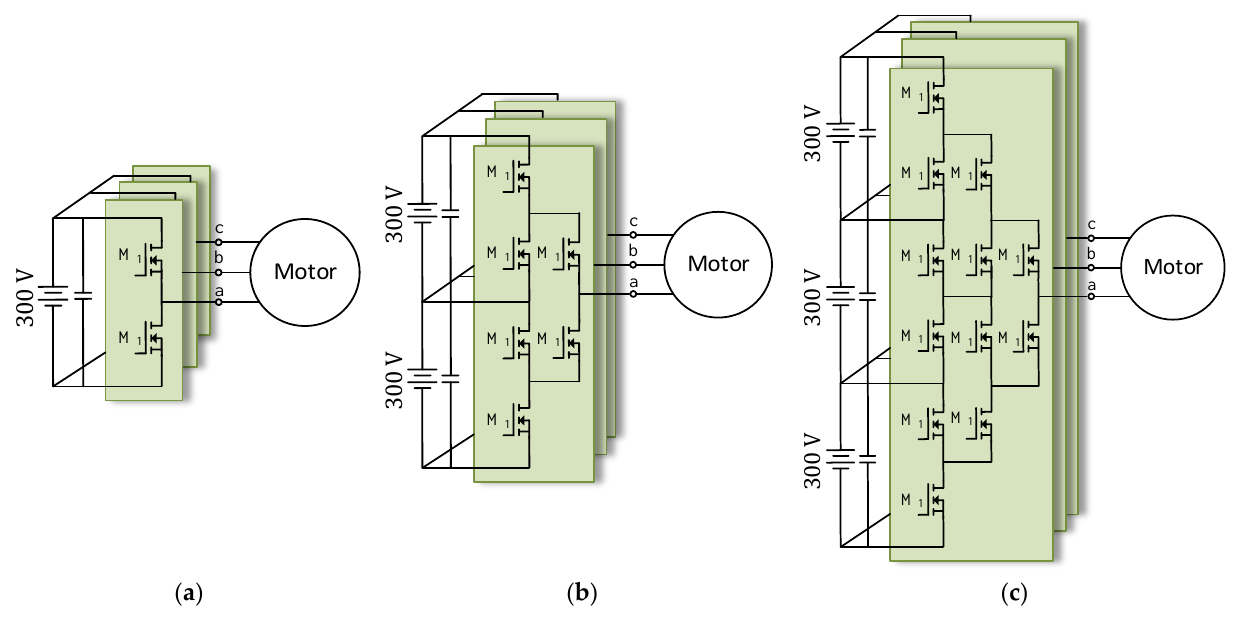
Figure 2. Design B. ( a ) EV 1 . ( b ) EV 2 . ( c ) EV 3 (for the sake of simplicity, the diodes in antiparallel with the MOSFETs have been intentionally omitted). the MOSFETs have been intentionally